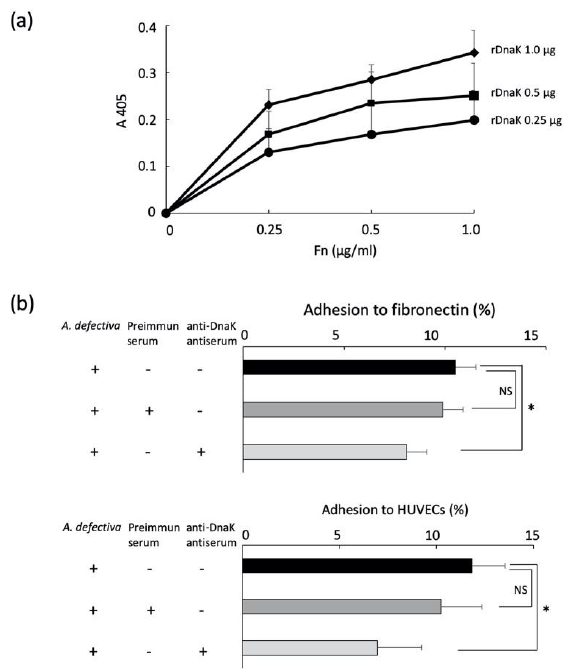
Figure 2. Binding of rDnaK to immobilized fibronectin, and the binding of A. defectiva to immobilized fibronectin or HUVECs. The indicated amounts (0.25, 0.5, and 1.0 µ g/mL) of rDnaK/100 µ L were added, and the fibronectin immobilized plate was incubated for 2 h at RT. The wells were washed three times with PBS, incubated with a rabbit anti-His affinity-purified antibody (1:1000) for 1 h at RT, and then incubated with an alkaline phosphatase-conjugated monoclonal anti-rabbit IgG for 1 h at RT. Alkaline phosphatase activity of each well was detected using 5 mM disodium p -nitrophenyl phosphate in 50 mM glycine and 0.5 mM MgCl 2 , and the absorbance at 405 nm was measured ( a ). One hundred microliters of radioactively labeled A. defectiva (10,000 cpm; 1 × 10 6 CFU) were added to the wells of a 96-well microtiter plate immobilized with 2.0 µ g of fibronectin. After 90 min incubation at 37 ◦ C, the adherent bacteria were collected in a vial containing liquid scintillator and counted using a scintillation counter. The bacteria (10,000 cpm; 1 × 10 6 CFU) were added to a 12-well plate with a semiconfluent culture of HUVECs (10 5 cells/well) at a multiplicity of infection of 10. After 90 min incubation at 37 ◦ C, the adherent bacteria were removed, collected, and then counted using a scintillation counter, as described previously ( b ). In some experiments, 100 µ L of radioactively labeled A. defective that was pretreated with anti-DnaK antiserum diluted in the 1:200 or preimmune antiserum (dilution 1:200) for 1 h at RT was used. Data are expressed as the mean ± SD from three independent experiments, each performed in duplicates. Six samples were analyzed in each group. Statistically significant differences; NS, not significant, * p <